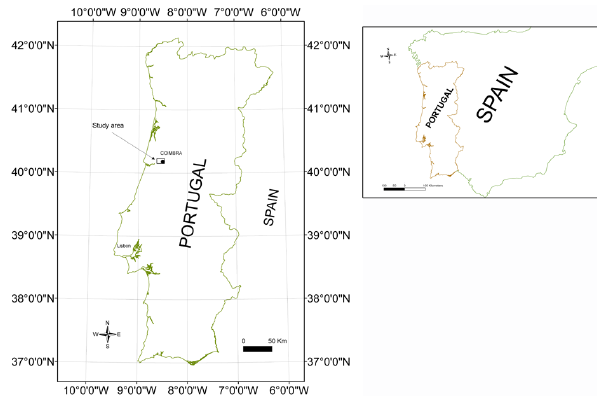
Fig. 1. Location of the study